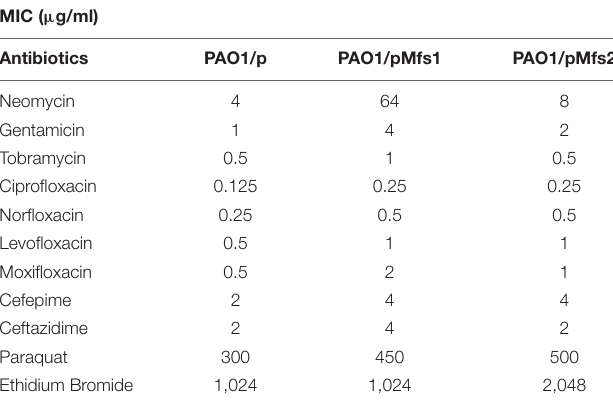
TABLE 1 | MIC values against PAO1/pMfs1 and PAO1/pMfs2 of aminoglycosides, quinolones, cephalosporins, paraquat, and ethidium